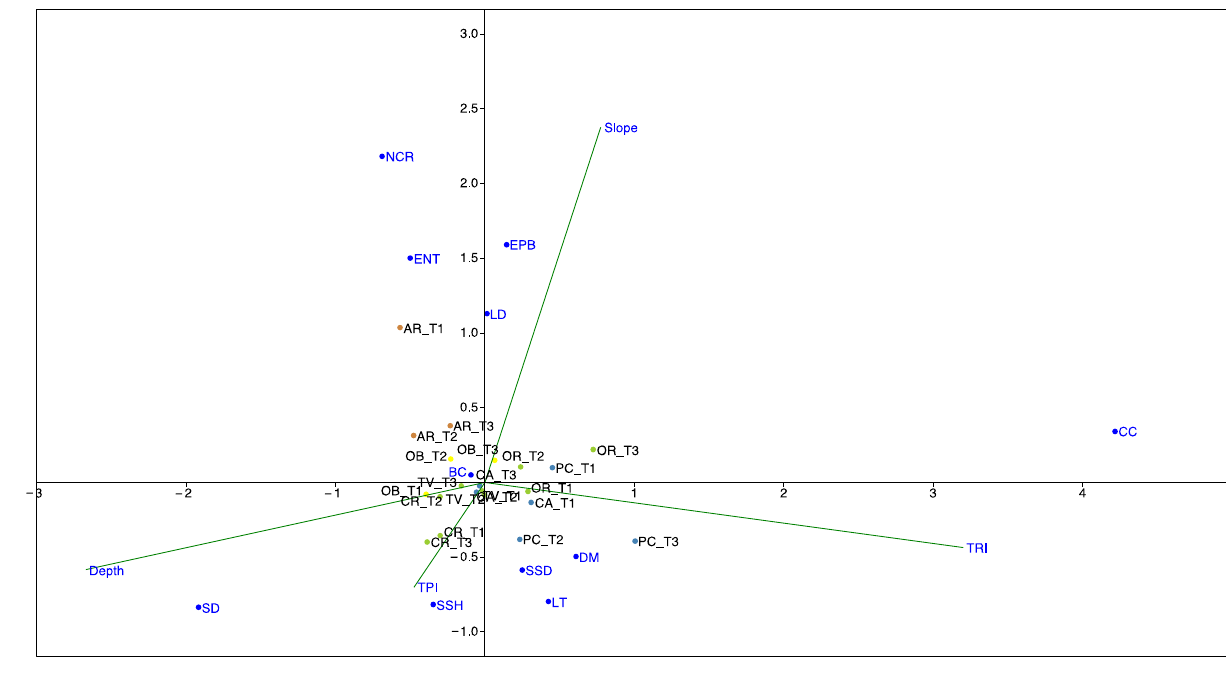
Figure 5. Outputs of the canonical correspondence analysis (CCA) performed using environmental variables (depth, slope, TRI, and TPI) and the 12 metrics used to assess the environmental status of the 7 sites (blue dots). SR: species richness; BC: living basal layer cover; CC: coralline algae cover; DM: dominant structuring species; SSD: density of all structuring species; SSH: mean height of the dominant structuring species; SD: sediment, ENT: percentage of colonies directly entangled in marine litter or fishing gear; NCR: percentage of colonies showing necrotic portions; EPB: percentage of colonies showing parts with epibionts; LD: density of marine litter LT: type of litter. Sites are labelled with site_transect number and coloured according to their environmental status.